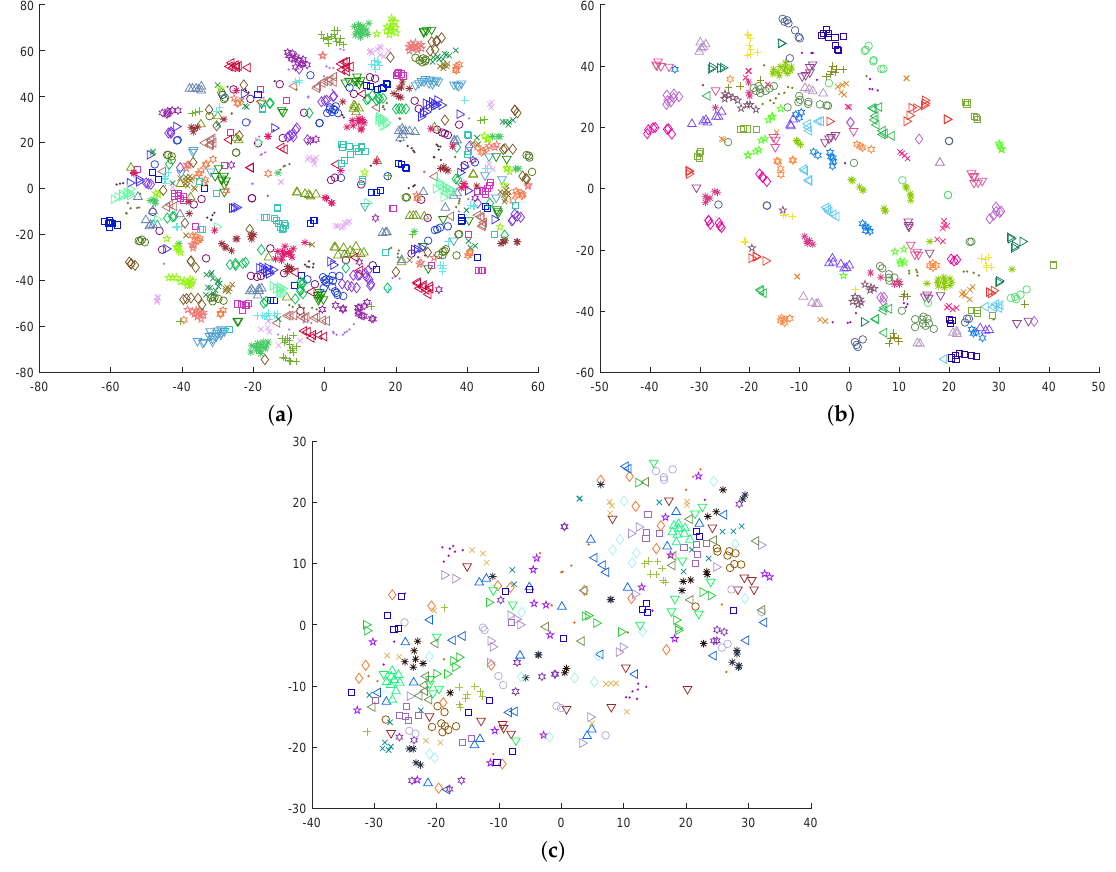
Figure 3. Dimensionality reduction by t-SNE, after transforming the data by binarizing values according to whether they are lower or greater than the median: ( a ) DEAP; ( b ) MAHNOB-HCI; and ( c )